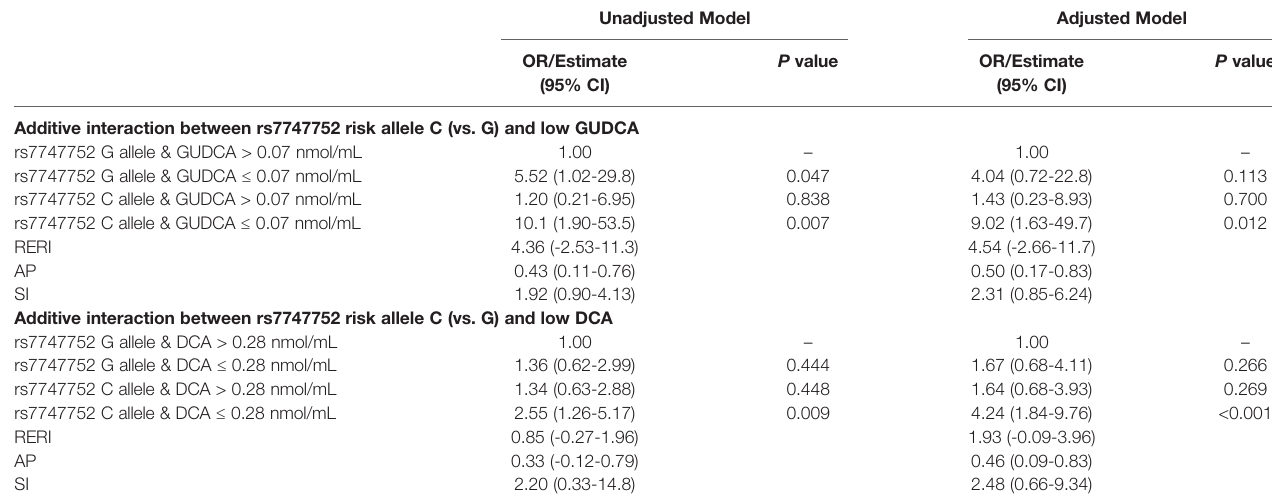
TABLE 4 | Additive interactions between rs7747752 C allele (C vs. G) and low GUDCA/DCA for the risk of gestational diabetes